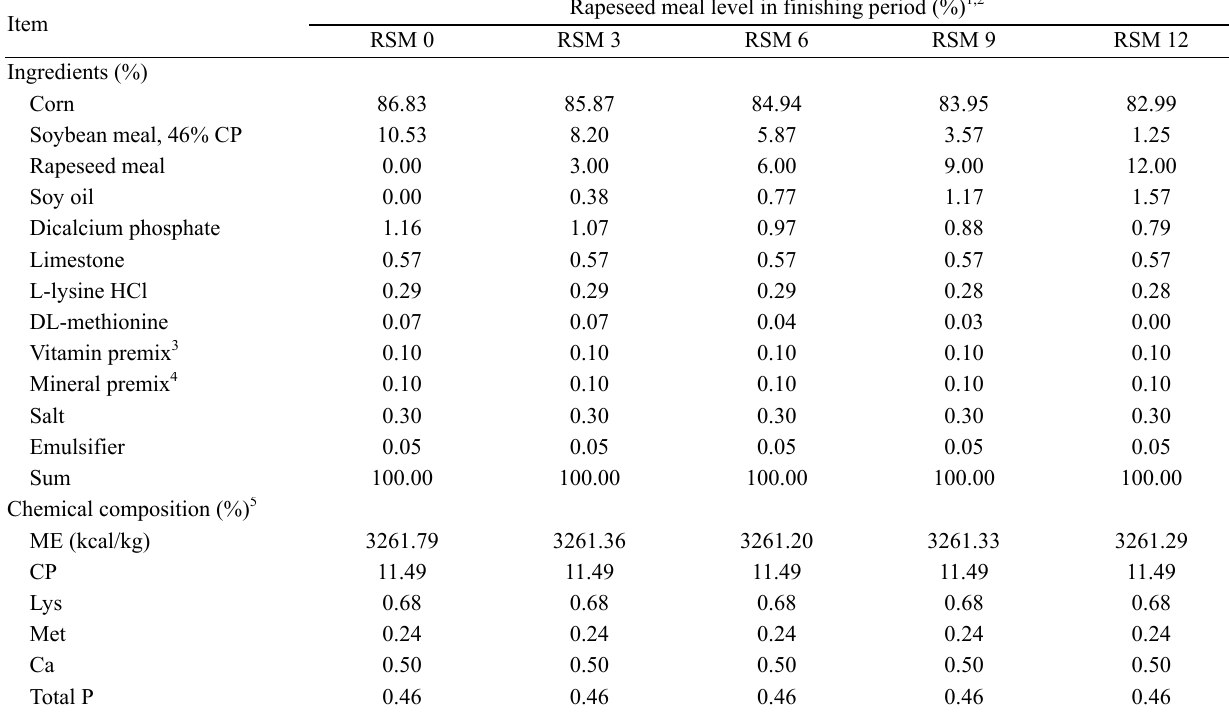
Table 3. The formula and chemical composition of experimental diets in finishing period (as-fed basis)